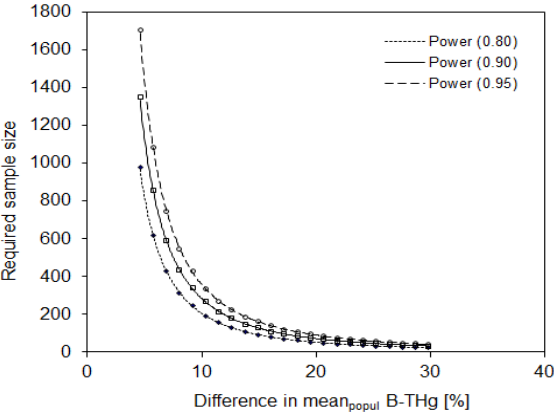
Figure 2. The sample size required to reveal a significant difference in blood Hg levels between two population groups, assuming that all analyses are performed in one laboratory. Statistical power = 0.80, 0.90, and 0.95; α = 0.05; one-sided.